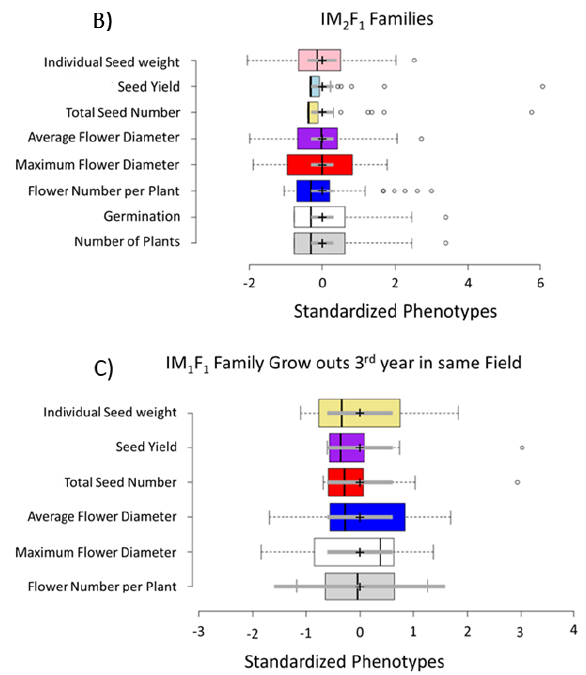
Figure 1. Phenotypic ranges are shown as standardized phenotypes in ( A ) IM 1 F 1 half-sib families in the first two years; ( B ) IM 2 F 1 families in the first year; and ( C ) IM 1 F 1 families, evaluated as the third year after being in the same plots for three consecutive years. In the boxplots the center lines show the medians and box limits indicate the 25th and 75th percentiles. The whiskers extend 1.5 times the interquartile range from the 25th and 75th percentiles. The outliers are represented by dots and the crosses represent sample means